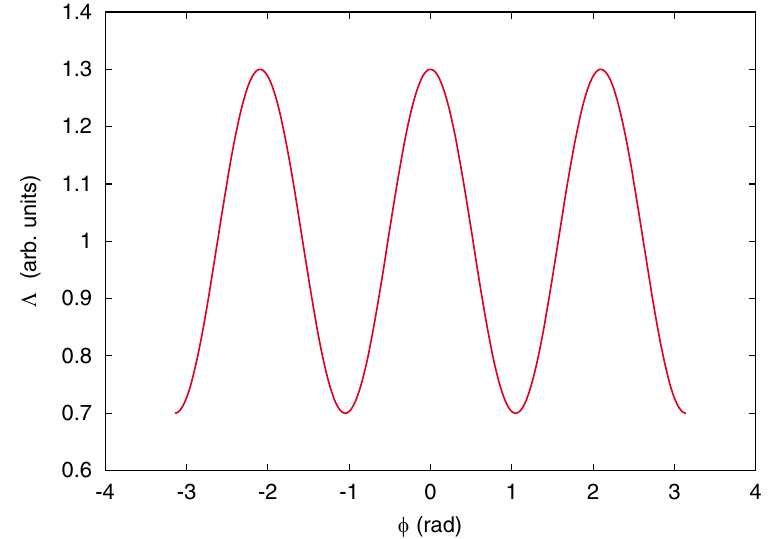
FIG. 10. (Color) The line density function used in the steady-state Hamiltonian formulation.